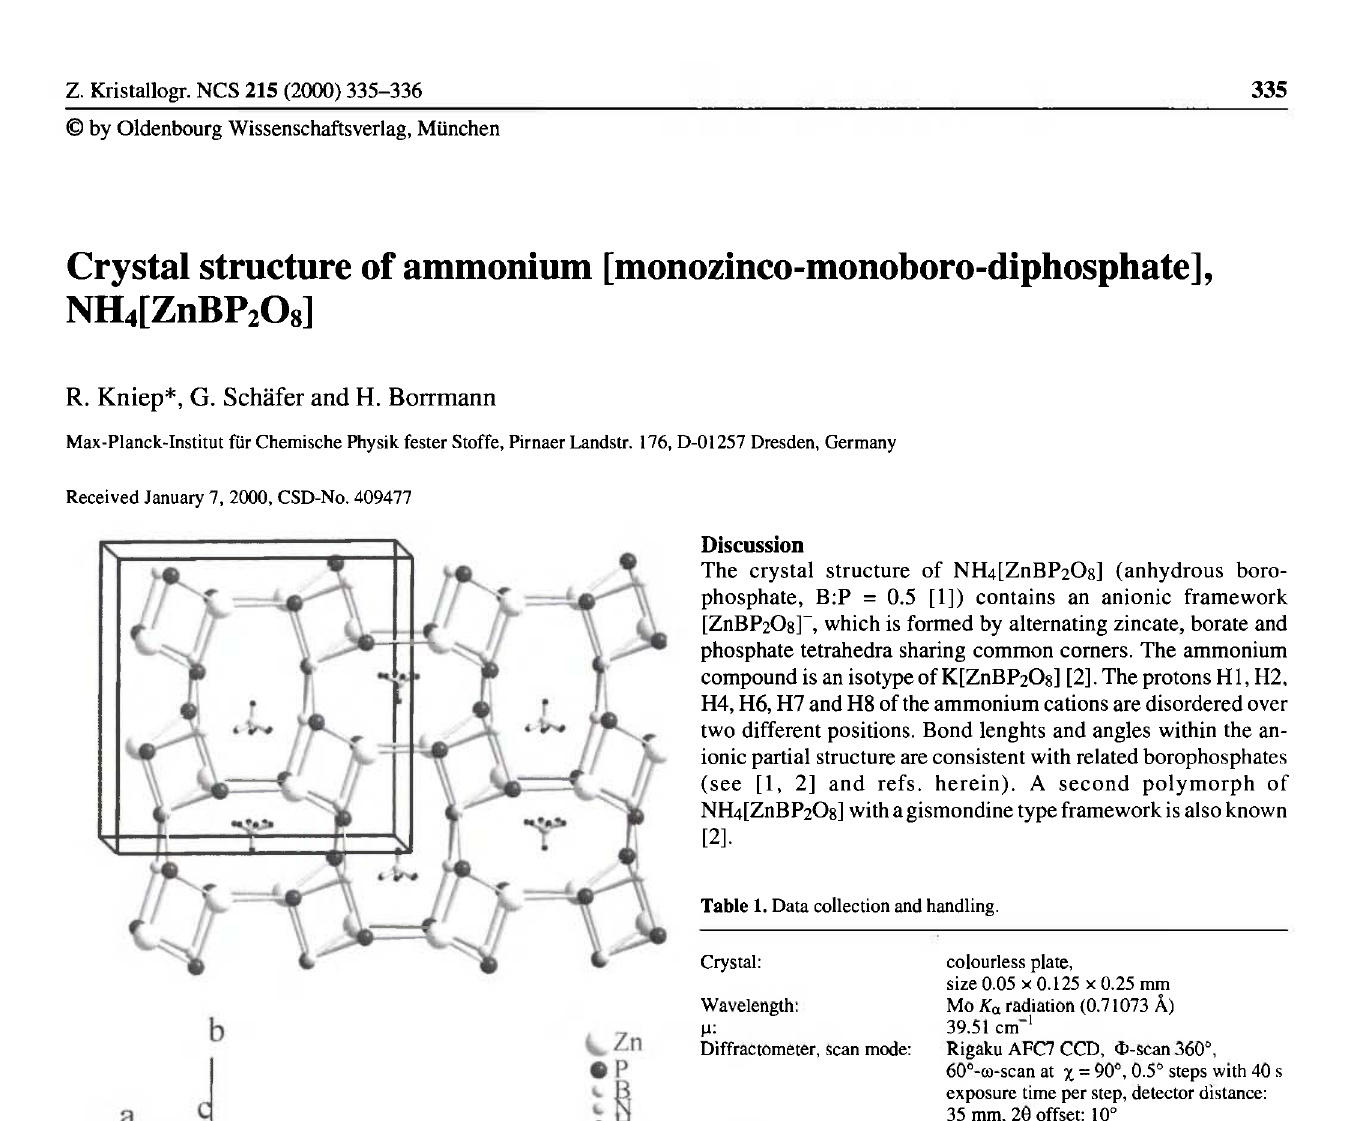
Table 2. Atomic coordinates and displacement parameters (in Ä 2